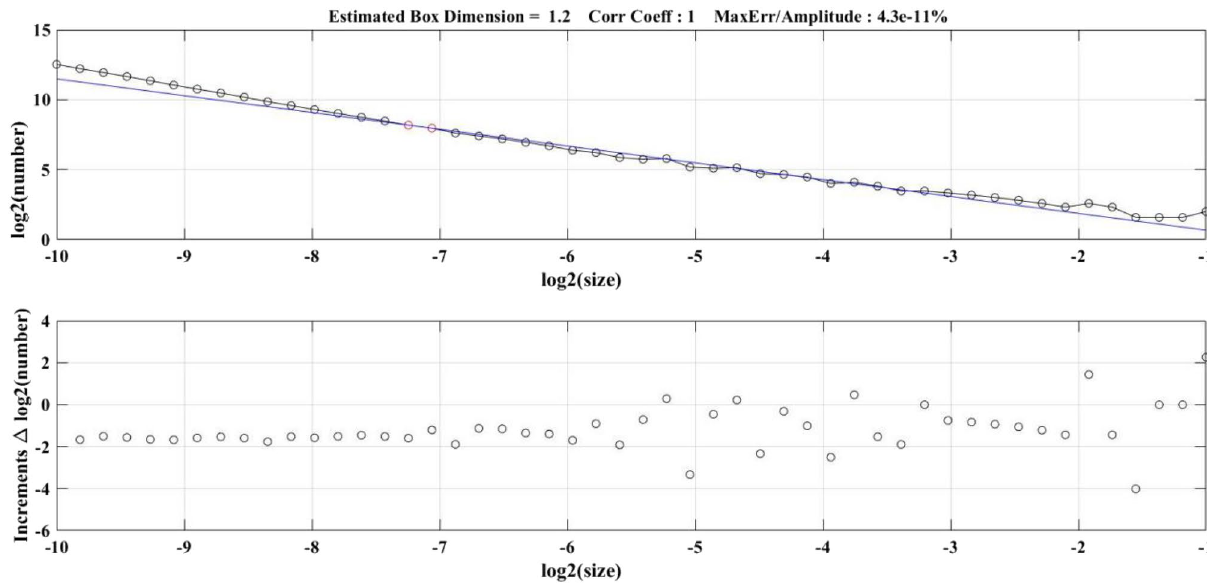
Figure 6. Condition 1: Log N δ ( F ) and log δ logarithm images of primary fractures in the original reservoir